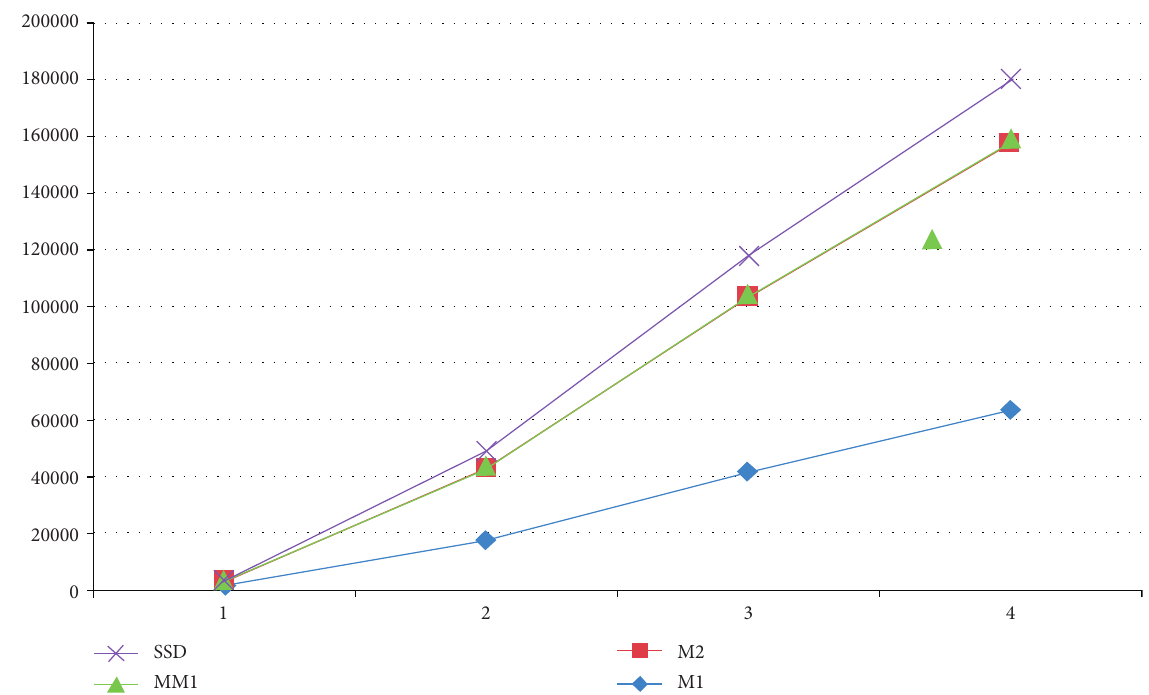
Figure 4: Graphical comparison between M and AZI ( Γ